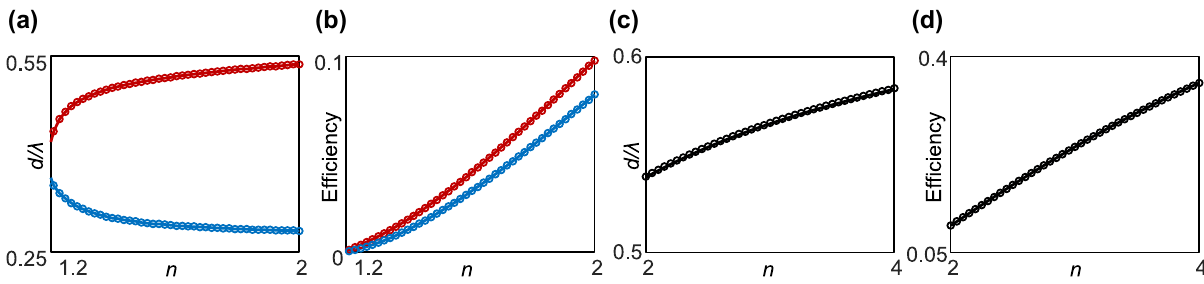
Figure 3: The precision enhancement for the broad n range. (a) d ∕ 𝜆 for Δ n → 0 and (b) efficiency along the curves in (a) for 1.15 ≤ n ≤ 2. (c) d ∕ 𝜆 for Δ n → 0 and (d) efficiency along the curve in (c) for the higher index regime (2 ≤ n ≤